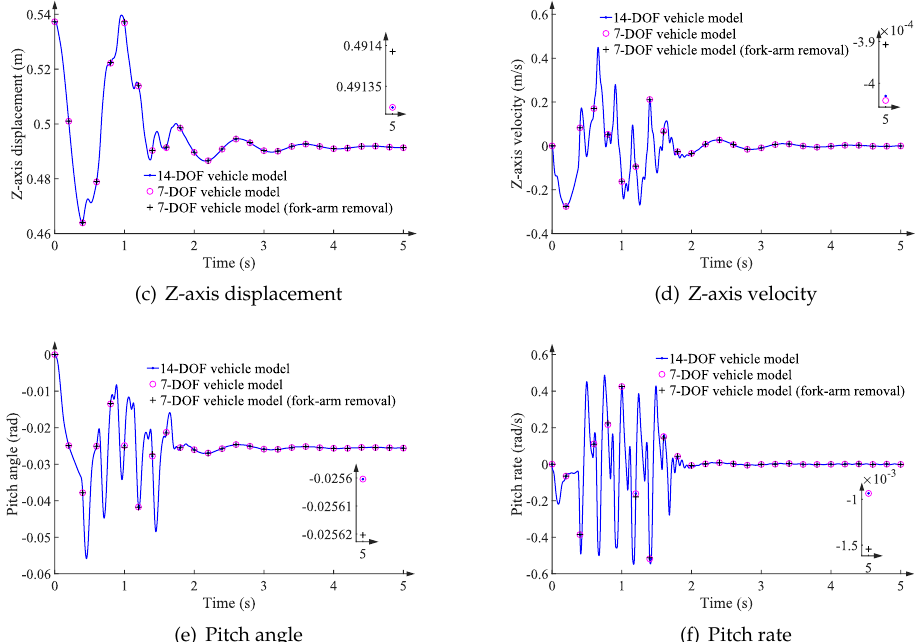
Figure 9. Results on the bumpy road with different vehicle models.